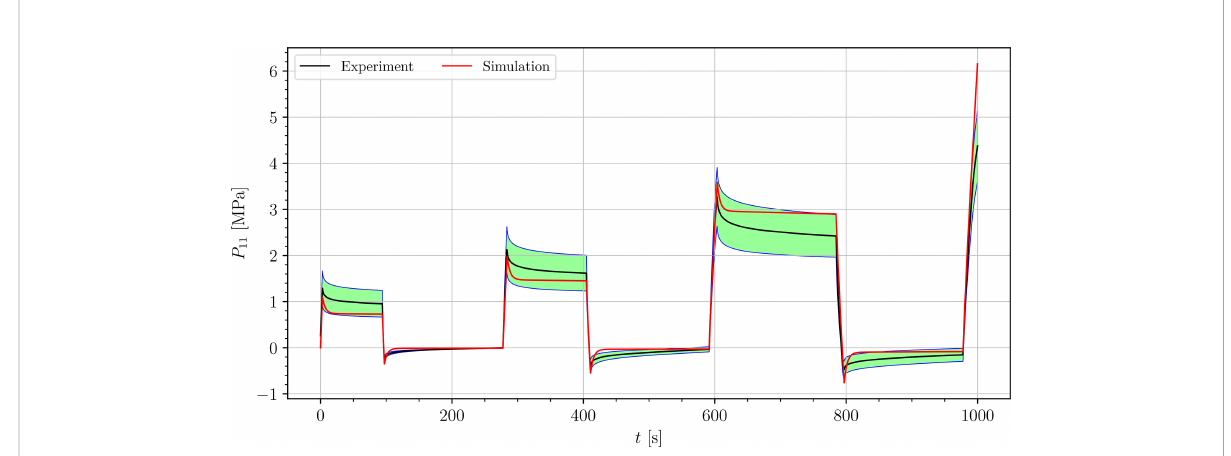
FIGURE 11 Simulation of the cyclic uniaxial tensile stress-relaxation test of the venation (red curve). Green region indicates a standard deviation from the averaged experimental result (black